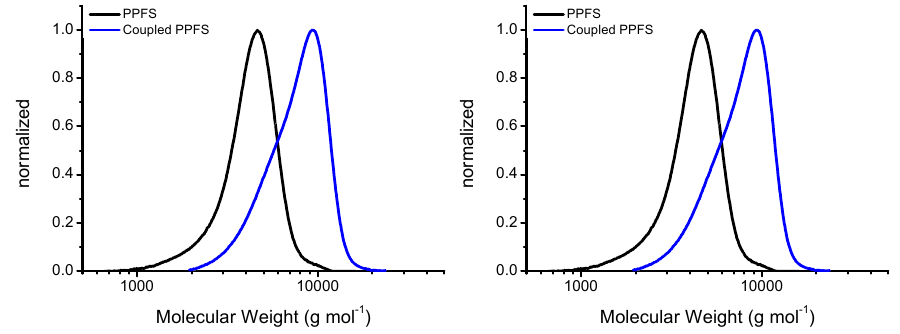
Figure 1. Gel Permeation Chromatography (GPC) analysis of PPFS chains (black) and coupled PPFS (blue) with DA-DCMA anchor.